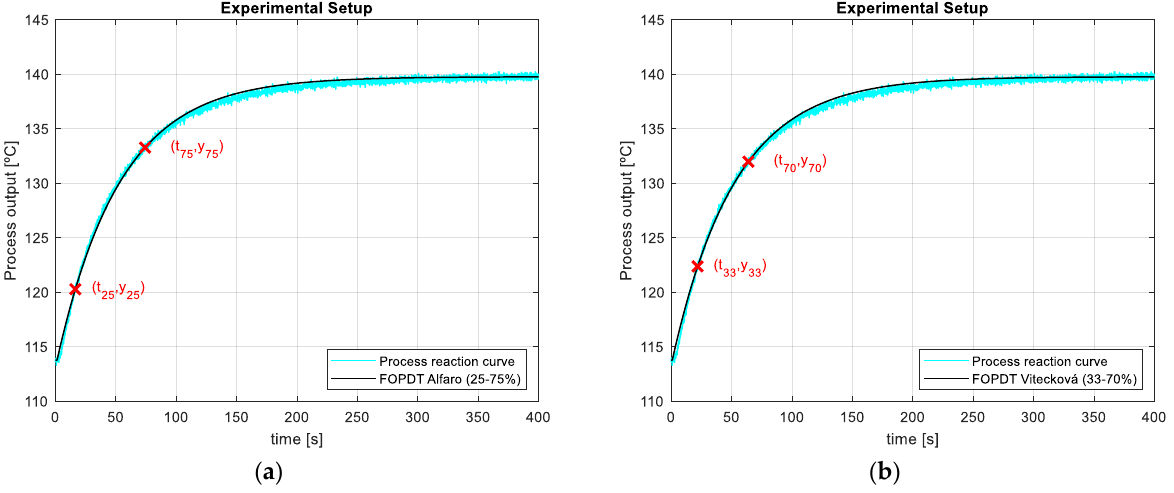
Figure 14. Process reaction curve in a certain operating point (Configuration #2) and FFOPDT model step response using the identification method proposed in [42] for the experimental setup: ( a ) Symmetrical set of points (5-50-95%); ( b ) Asymmetrical set of points (20-60-95%).